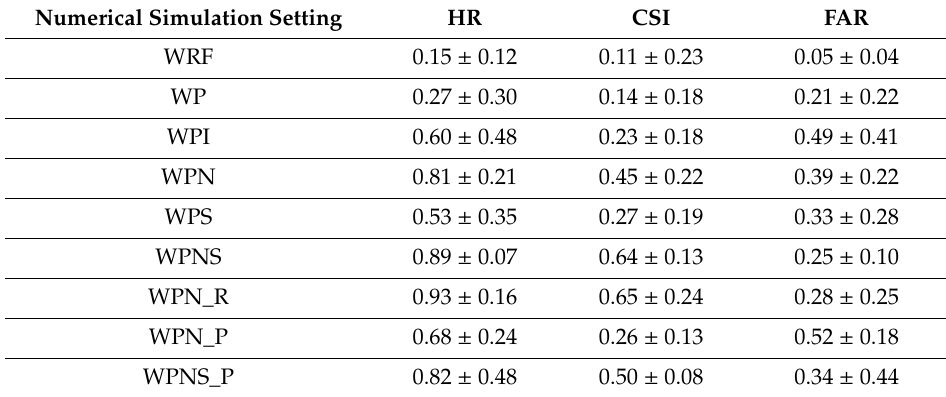
Table 4. Model performance statistics for di ff erent numerical simulation settings. Shown are average and standard deviation of hit rate (HR), critical success index (CSI) and false alarm rate (FAR). Numerical Simulation